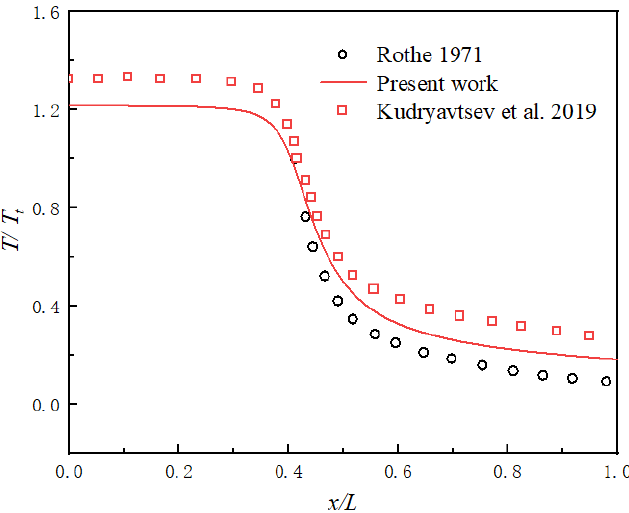
Figure 2. Distribution of the dimensionless temperature of gas along micronozzle centerline.